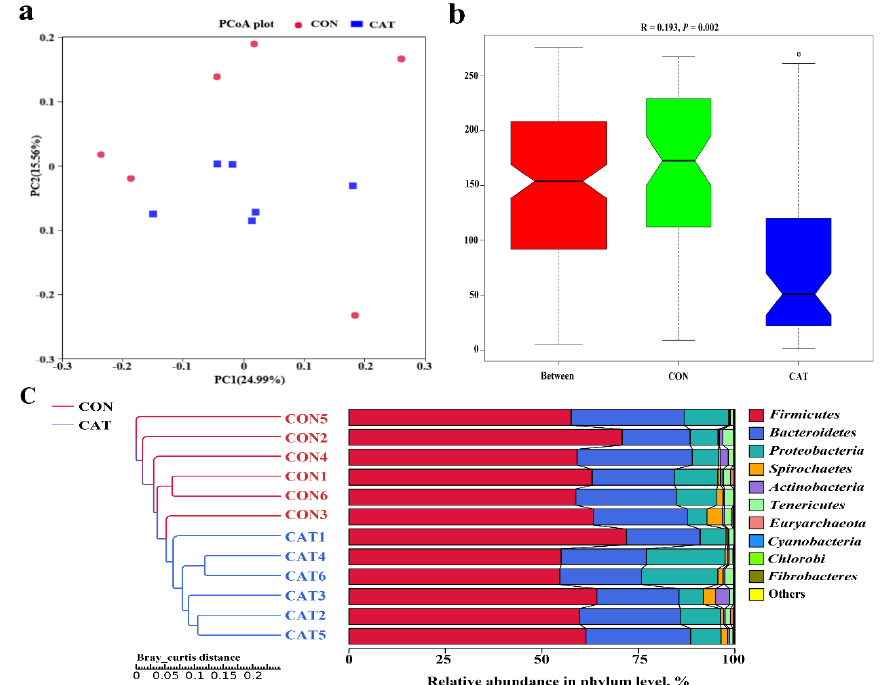
Figure 4. The beta diversity of microbial communities in two treatments. ( a ) The principal coordinate